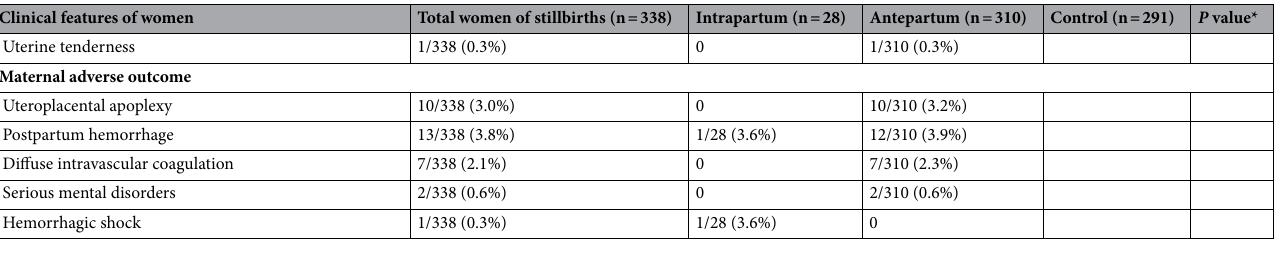
Table 2. Clinical features of women who had stillbirths during the current pregnancy. Data are n/N (%). *Comparison of antepartum and control